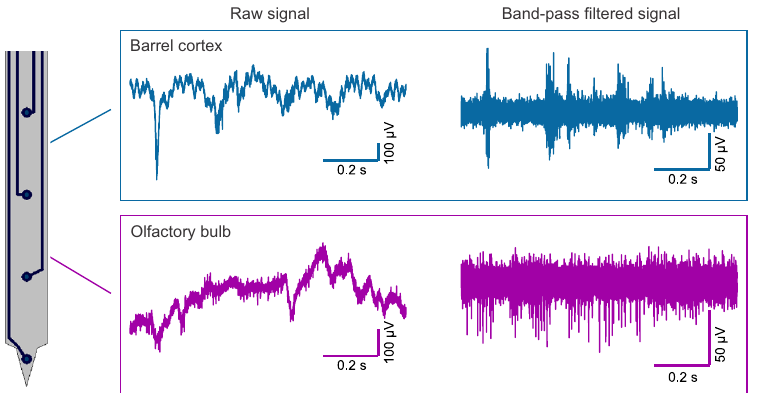
Figure 3. Representative electrophysiological recordings using the flexible neural probes. 1 s raw and band- pass filtered traces (5th order Butterworth band-pass, 300 Hz–10 kHz) from the mouse barrel cortex and the olfactory bulb.